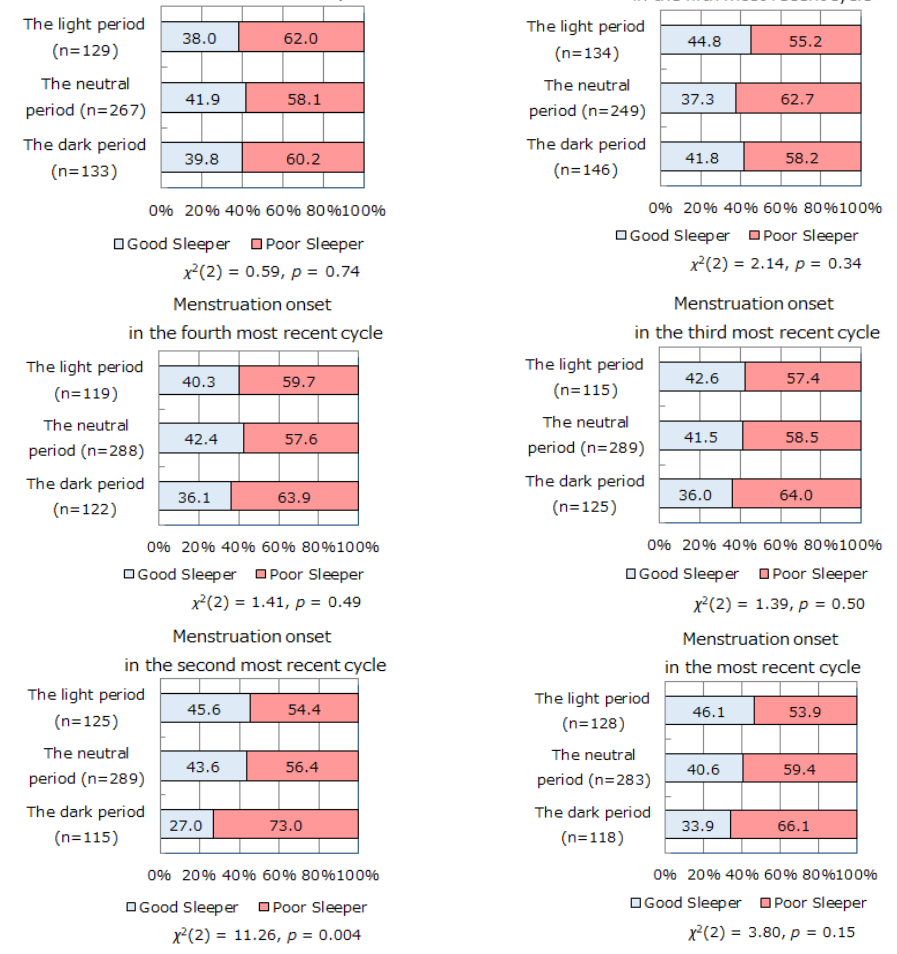
Figure 3. The proportions of good sleepers and poor sleepers with menstruation onset in the light/dark/neutral periods during their six most recent menstrual cycles. The proportion of subjective poor sleepers was significantly higher in participants with menstrual cycle onset in the dark period than in those with onset in the light period, in the second most recent menstrual cycle. The same tendency was observed in the most recent menstrual cycle.